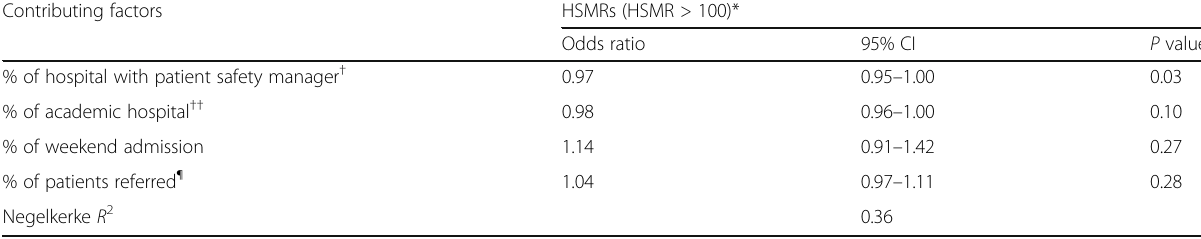
Table 3 Factors influencing HSMR in pneumonia patients (9-year model, 2010 – 2018, n = 33) Contributing factors